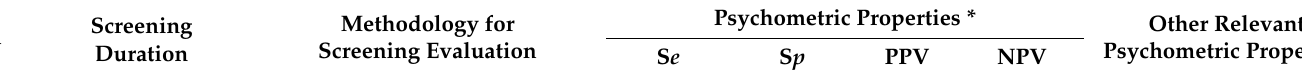
Table 2. Analysis of the studies included in the